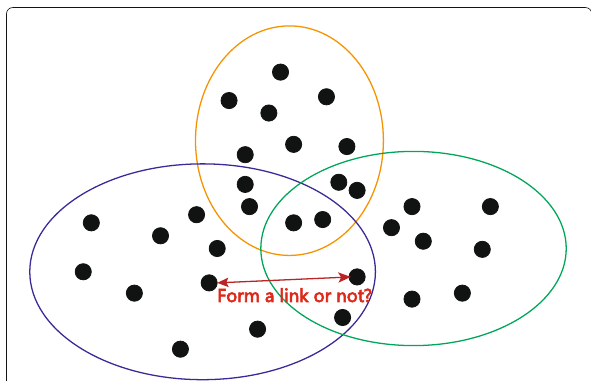
Fig. 1 Graphical illustration of the interactions of nodes to form links. Each circle corresponds to a community in the network. Each pair of nodes interacts to decide whether to form a link with each other or not. The utility function of the interactions depends on the community affiliations of the nodes